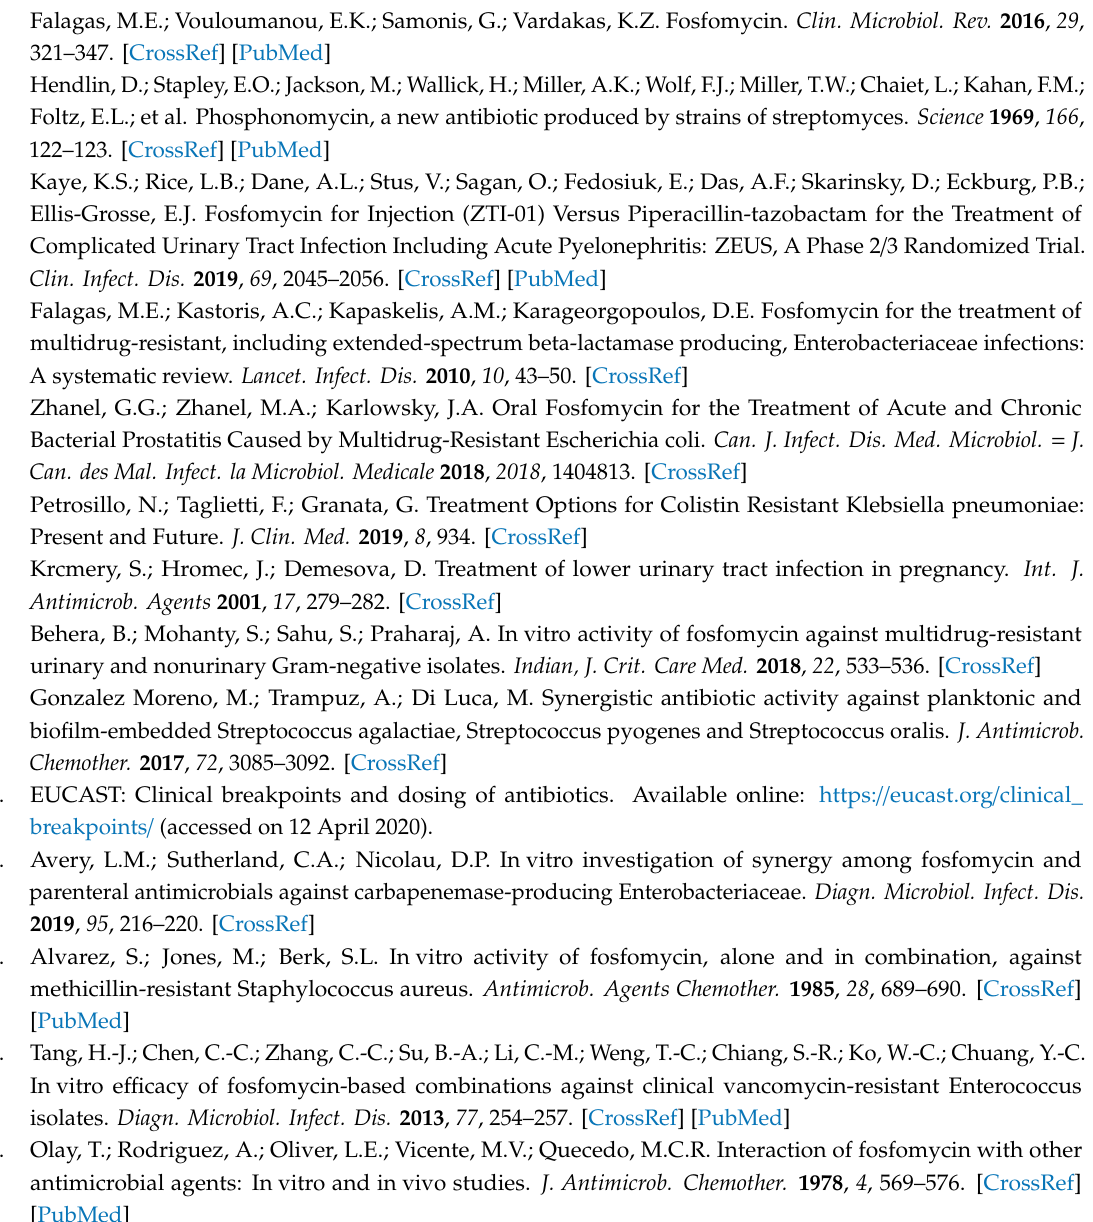
Table S1: Studies on combination between fosfomycin and di ff erent antibiotics. CB: checkerboard assay; TK: time–kill assay; ET: E-test, Table S2: Studies on combination between fosfomycin and molecules other than antibiotics. CB: checkerboard assay; TK: time–kill